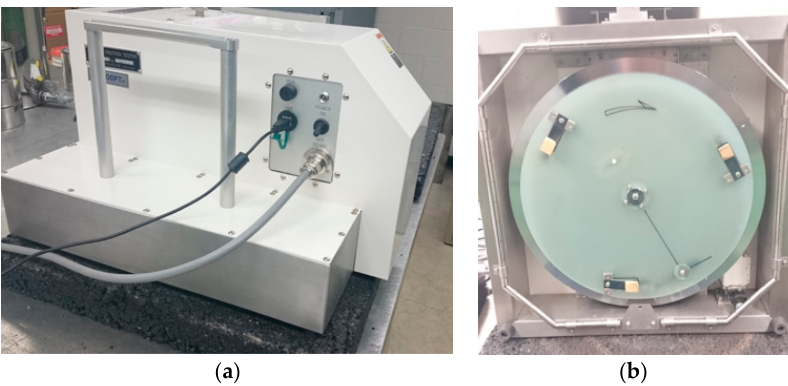
Figure 4. Prepared rubber sliders from test rubber materials.